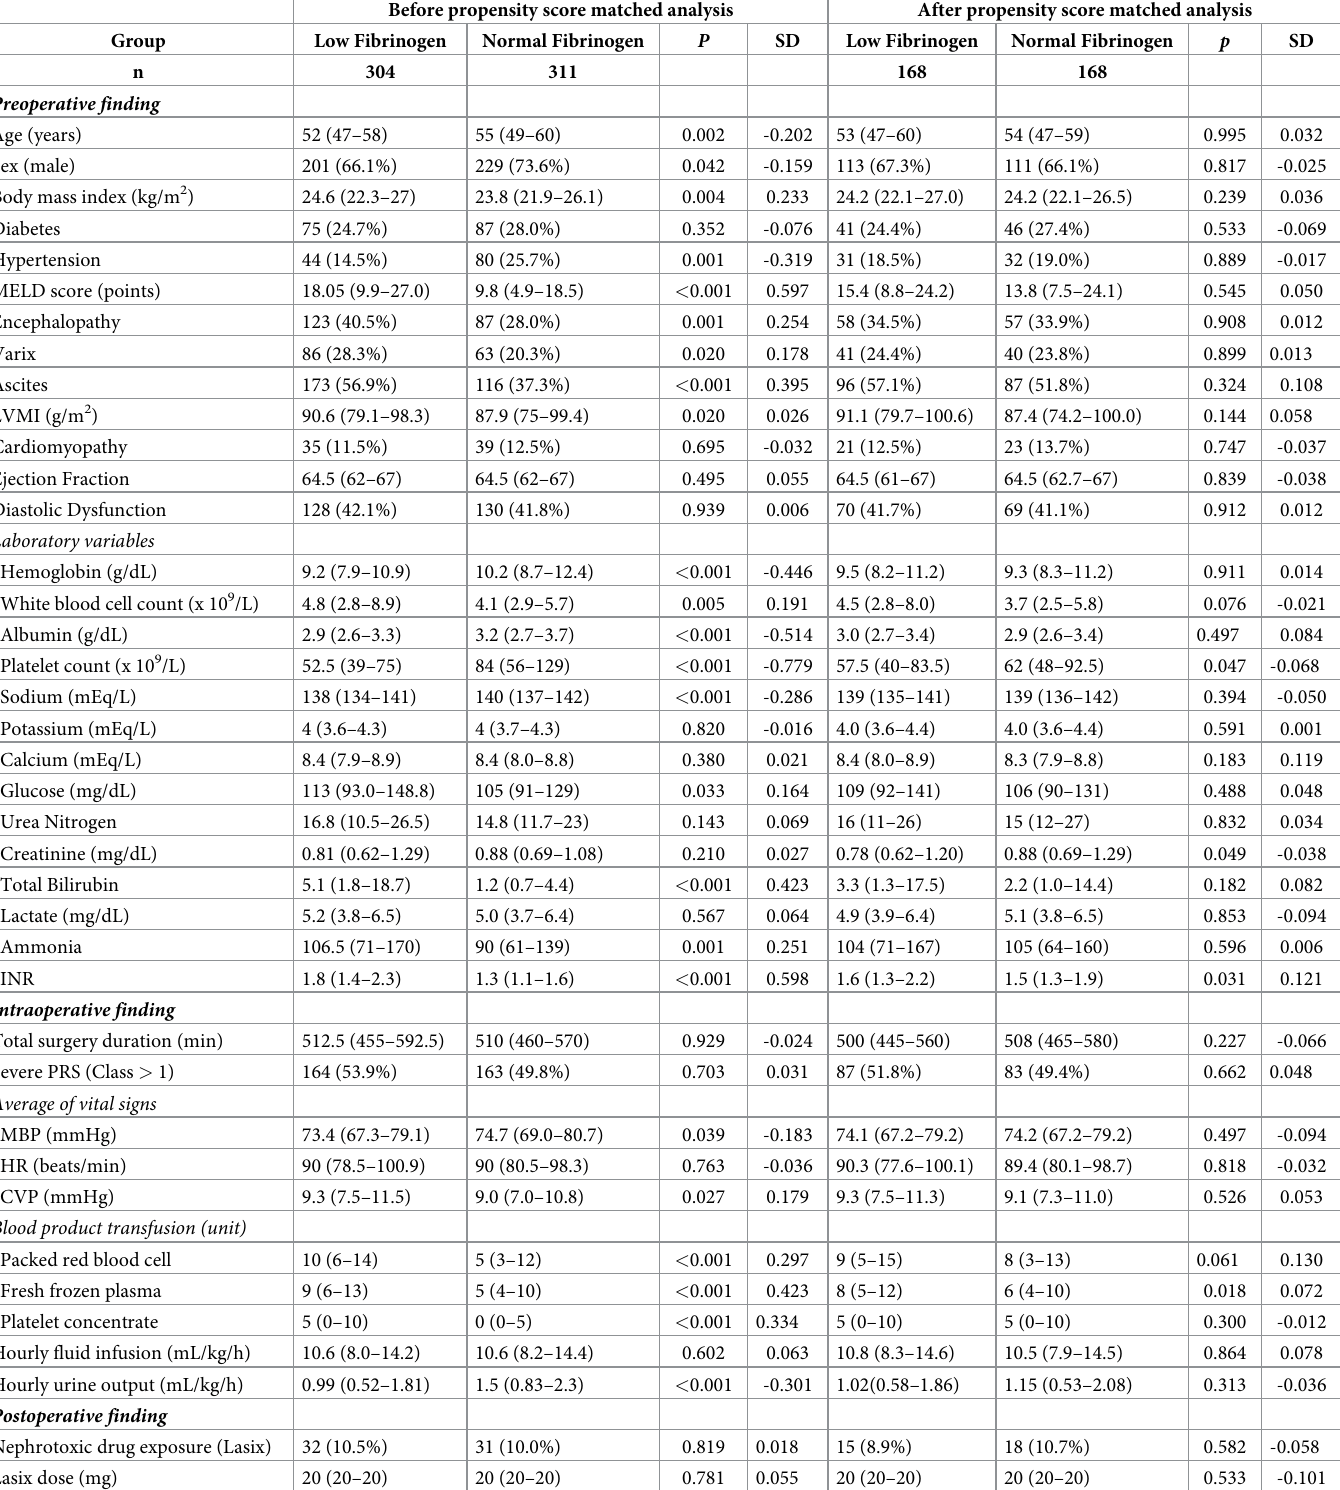
Table 1. Comparison of perioperative findings between the low and normal fibrinogen groups using propensity score matching analysis. Before propensity score matched